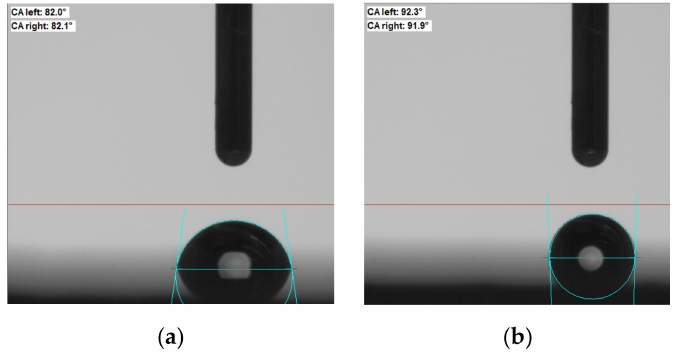
Figure 1. Change in the wetting angle for the pure MgF 2 ( a ) and for the MgF 2 + CNTs ( b ).